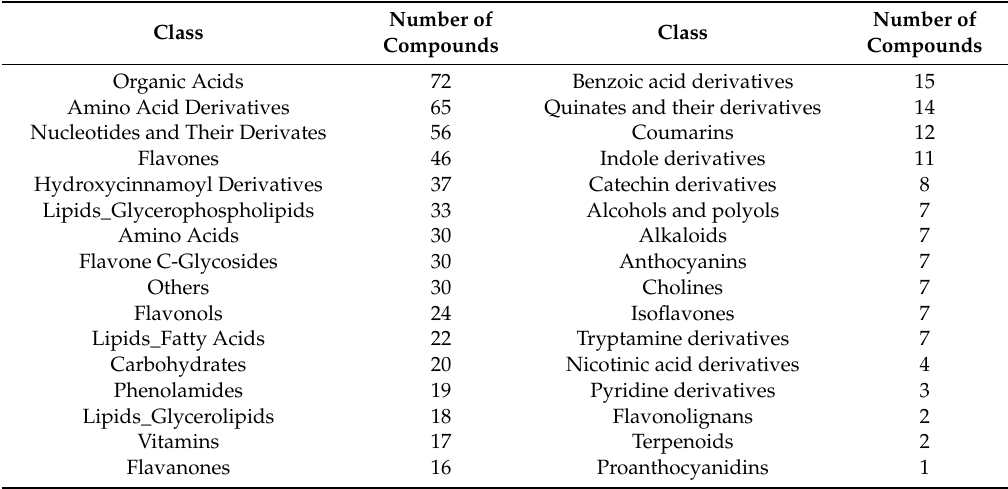
Table 1. Classification of the 649 detected metabolites in D. o ffi cinale leaves and stems. Number of Class